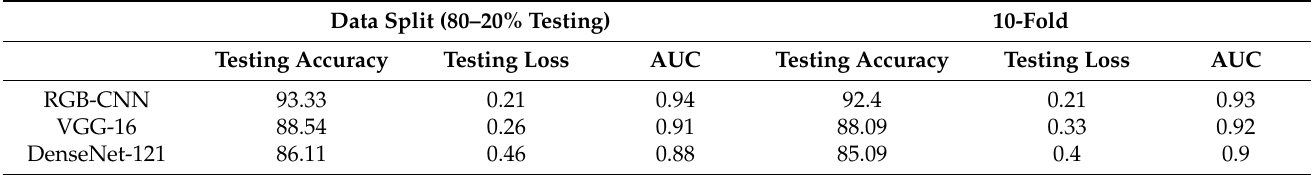
Table 12. Comparison between proposed RGB-CNN and pre-trained networks in testing metrics and AUC, following the application of default data split method and